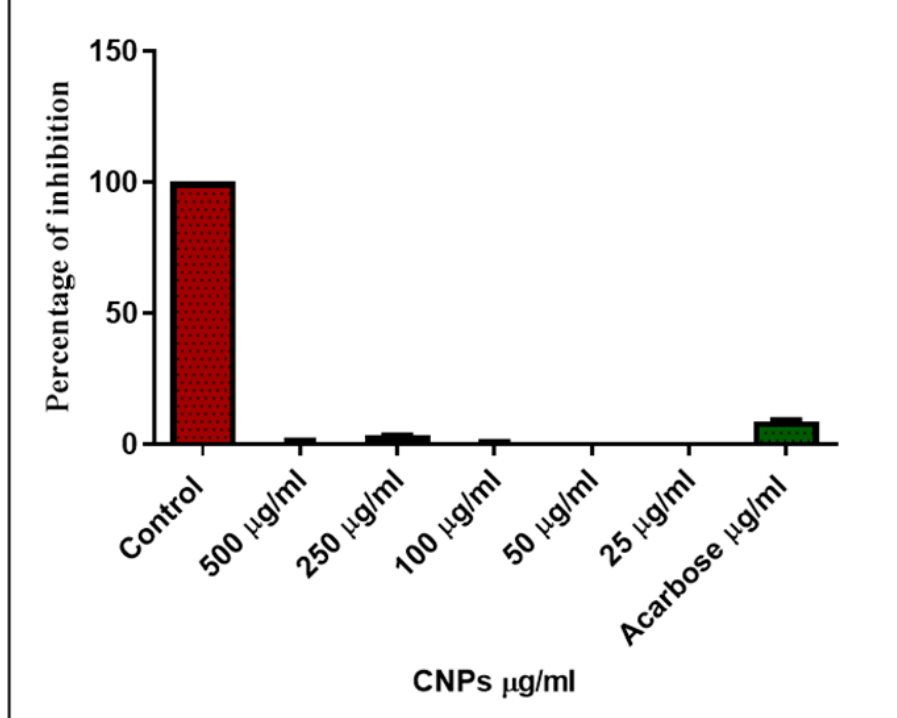
Figure 10. Percentage of α -amylase inhibitory activity assay with MAL-CNPs.